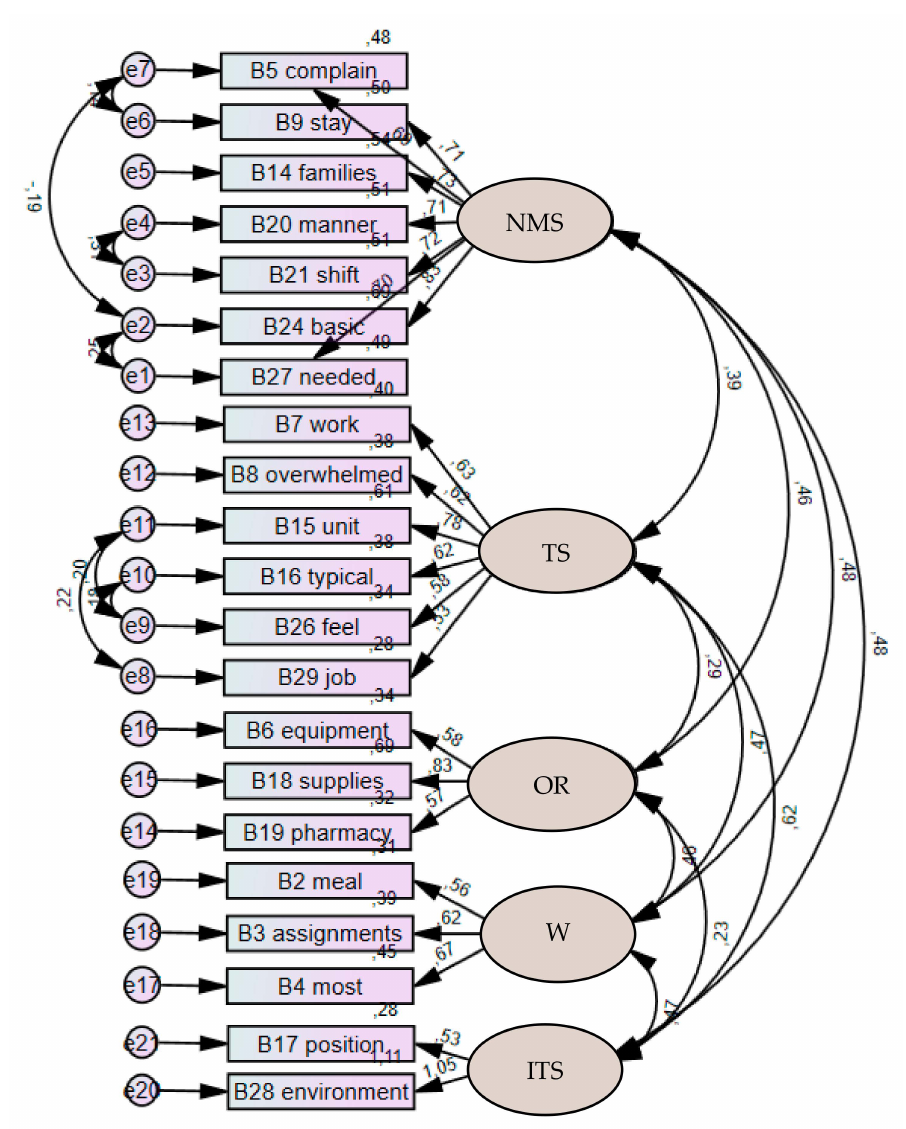
Figure 1. Five-factor model of